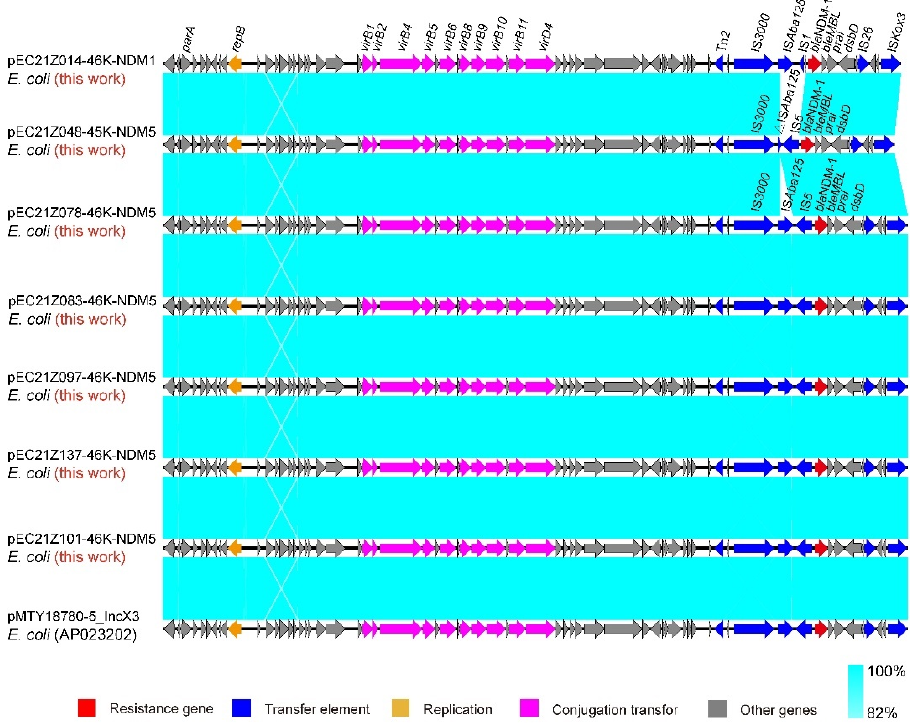
Figure 5. Sequence comparison of the IncX3 plasmids carrying bla NDM-1 and bla NDM-5 genes with the common plasmid backbone (pMTY18780-5_IncX3) in GenBank. Sequence similarity is shown in light blue. Arrows and triangles represent genes of different functional categories (red: resistance genes; dark blue: transfer elements; orange: replication; pink: conjugation transfer, grey: other genes).